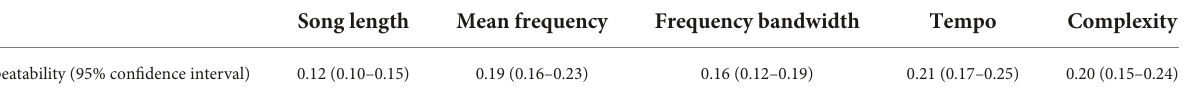
TABLE 1 Adjusted within-recording repeatability for the investigated song traits.